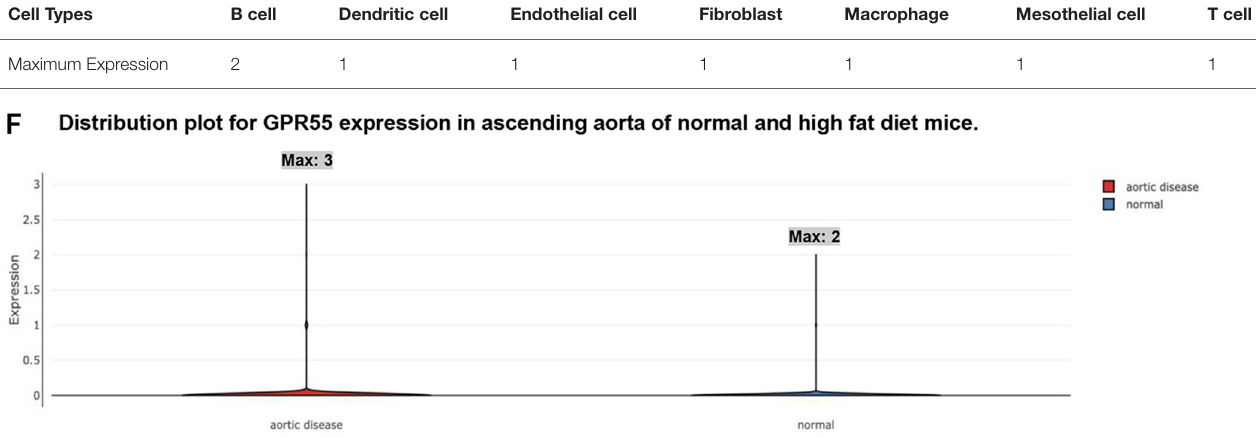
FIGURE 2 | G protein-coupled receptor 55 (GPR55) mRNA transcripts are found in endothelial cells in both human and mouse aortas. Moreover, the expression of GPR55 is upregulated in aortic disease. (A) Single-cell RNA-seq analyses were performed on the Single Cell RNA-Seq database of the Broad Institute of MIT and Harvard (Single-Cell RNA-Seq database portal for human thoracic aorta: https://singlecell.broadinstitute.org/single_cell/study/SCP1265/deep-learning-enables- genetic-analysis-of-the-human-thoracic-aorta?genes=GPR55#study-visualize (https://doi.org/10.1101/2020.05.12.091934); GPR55 expressions in macrophage, vascular smooth muscle cells, and endothelial cells of the human aorta are labeled with red arrows in the Scatter. (B) GPR55 expressions in endothelial cells of the human aorta were boxed in red in the Distribution. (C) The table shows the maximum expressions of GPR55 in each cell type. The expression unit should be the log 2 (TPM + 1). Note: (A–C) show the expression of GPR55 in humans. The single-cell transcriptional profiles in (B,C) from 54092 thoracic aortic cells singled out 14 clusters representing 13 cell types. (D) Single Cell RNA-Seq database portal for mouse study: https://singlecell.broadinstitute.org/single_cell/study/SCP1361/single- cell-transcriptome-analysis-reveals-cellular-heterogeneity-in-the-ascending-aorta-of-normal-and-high-fat-diet-mice?genes=Gpr55#study-visualize). GPR55 expressions in endothelial cells of mouse aorta were boxed in red in the Distribution. (E) The table shows the maximum expression of GPR55 in each cell type. (F) The expression of GPR55 increased in the high fat-fed aortic disease mouse model compared with the normal control mice. The expression unit should be the log 2 (TPM + 1). Note: The transcriptional profiles in (D–F) represent 24,001 aortic cells and 10 cell